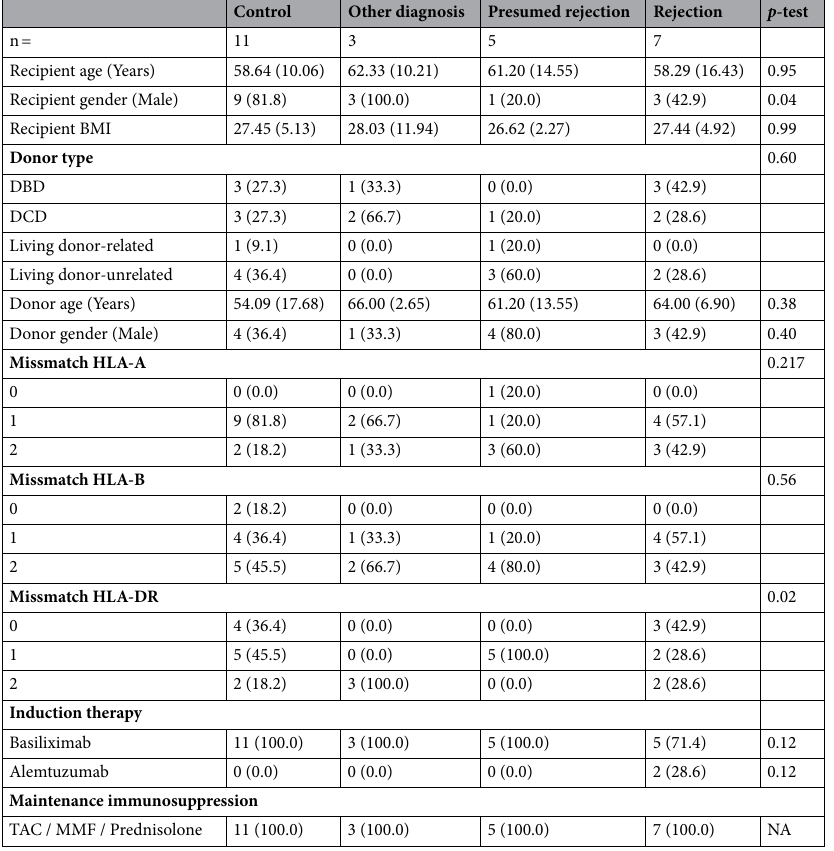
Table 1. Patient characteristics corresponding to the samples included in our analysis after exclusion of samples not passing the 95% reduction after detergent treatment. For the dd-EV analysis, samples from a total of 26 KTRs were included in the analysis (Fig. 4B). Continued variables are described as mean (SD). Categorical variables as number of cases (%). ATG Antithymocyte globulin, BMI Body mass index,